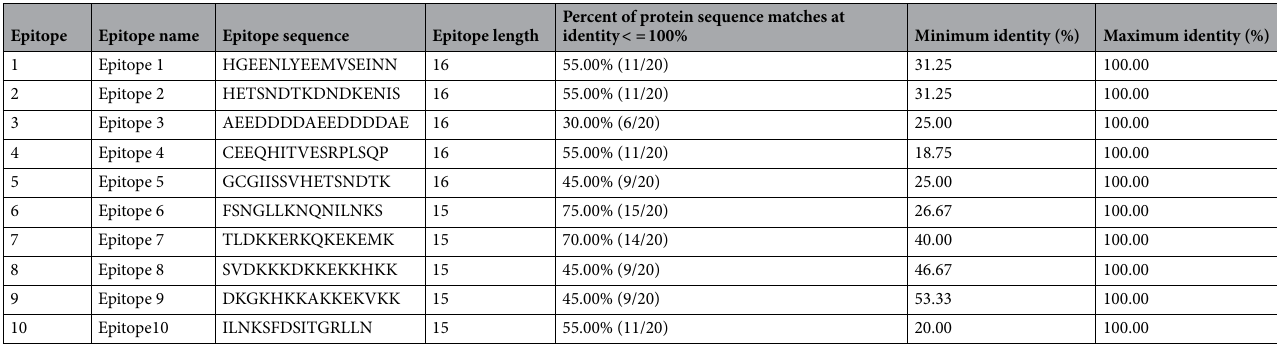
Table 3. Epitope conservancy degrees were analyzed using the tool (http:// tools. iedb. org/ conse rvancy). Epitopes are present in all homologous sequences with a conservancy degree from 20 to 100 percent. Epitope 7 is the most abundant.